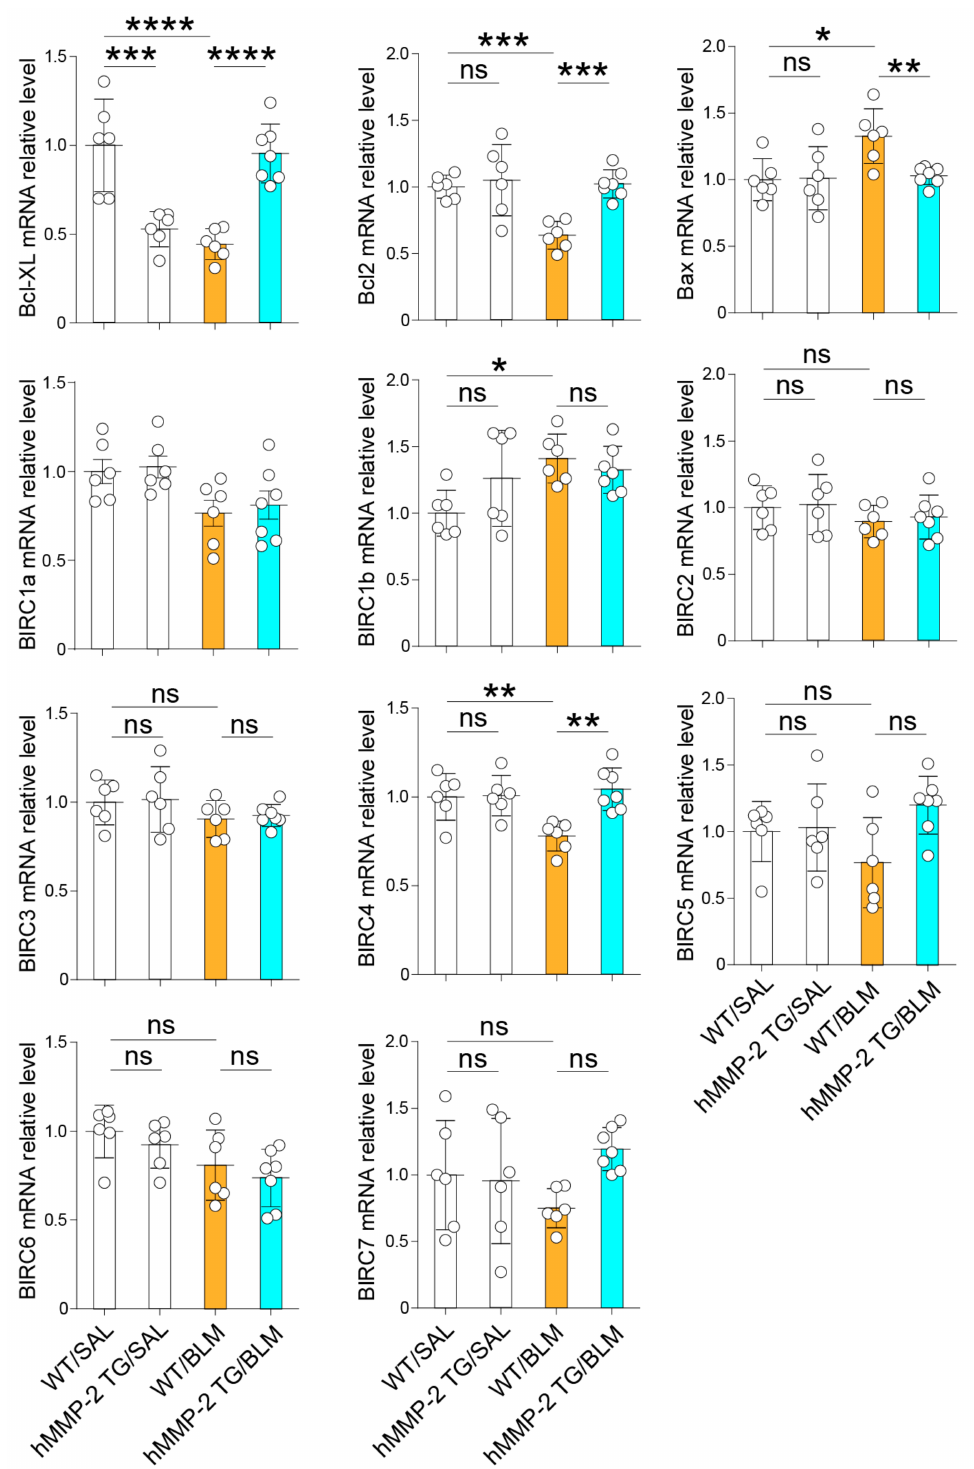
Figure 7. Inhibition of lung cell apoptosis by hMMP-2 overexpression. The total mRNA from the lungs of each mouse was extracted, and cDNA was synthesized using commercially available reagents. The number of mice: n = 6 in WT/SAL and hMMP-2 TG/SAL, n = 6 in WT/BLM, and n = 7 in hMMP-2 TG/BLM. Data are the mean ± S.D. All mice were female. Statistical analysis by ANOVA with Newman-Keuls test. **** p < 0.001; *** p < 0.001; ** p < 0.01; * p < 0.05. WT, wild-type; hMMP-2, human matrix metalloproteinase-2; SAL, saline; BLM, bleomycin; ns, not